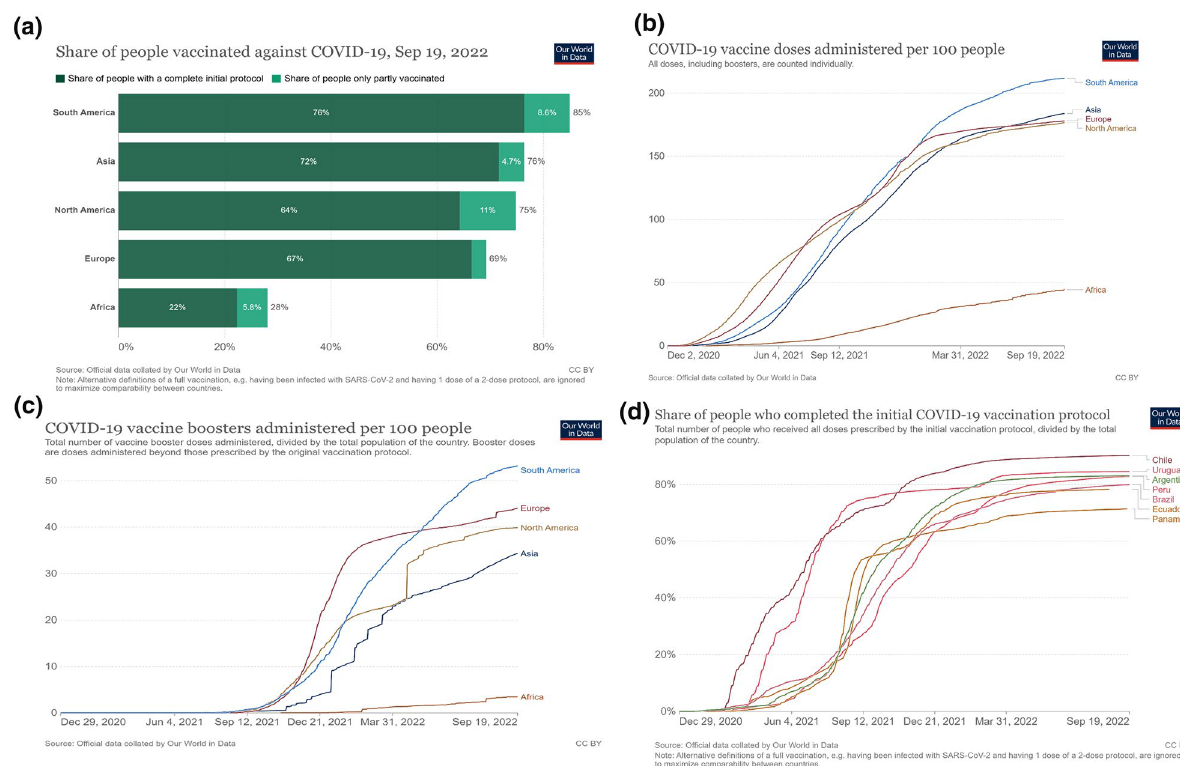
Fig. 1 a Share of population vaccinated against COVID‑19. Source : Edouard Mathieu, Hannah Ritchie, Lucas Rodés‑Guirao, Cameron Appel,